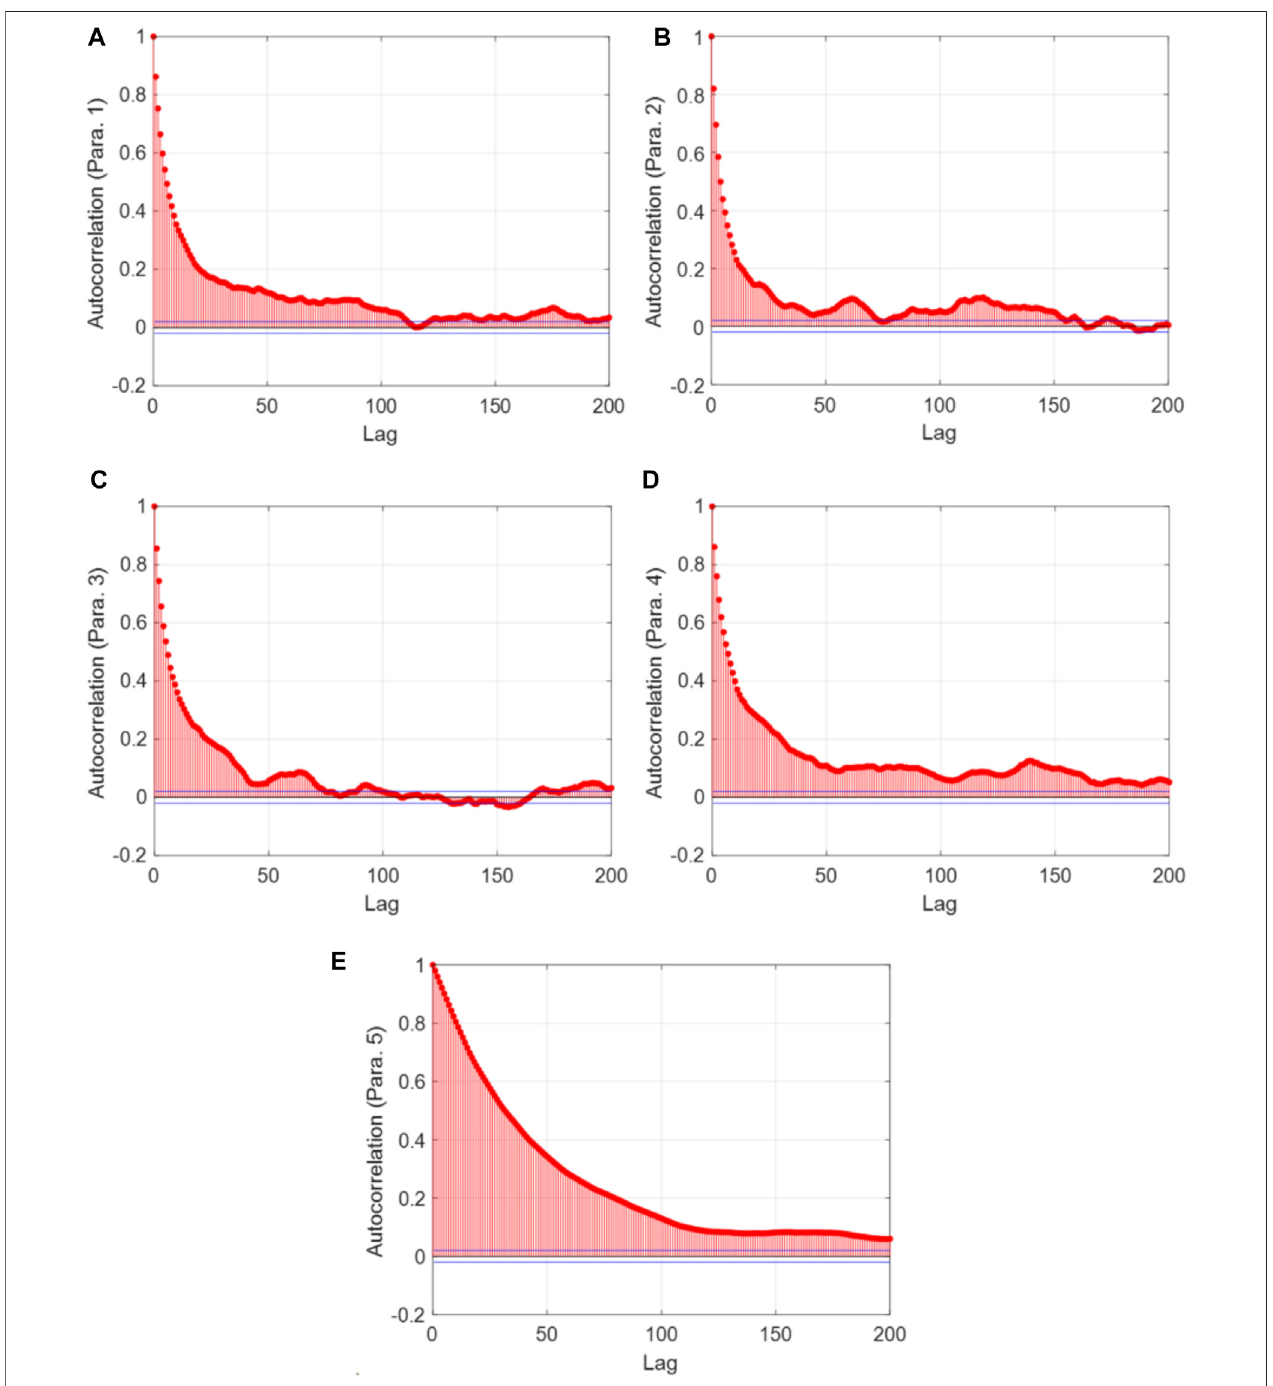
FIGURE 8 | Autocorrelation ofthe 1stMarkov chain with respect tolag. (A) Parameter 1; (B) Parameter 2; (C) Parameter 3; (D) Parameter 4; and (E) Parameter 5.